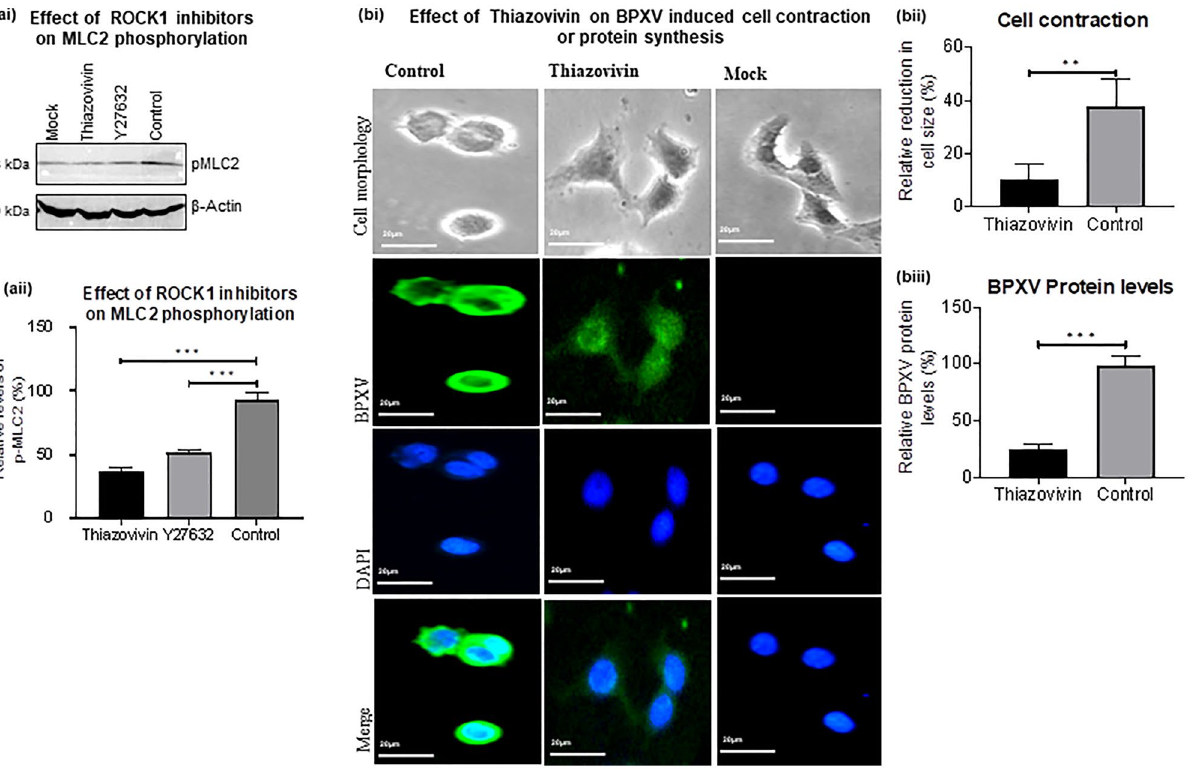
Figure 5. ROCK1 inhibition impairs BPXV-induced cell contraction and viral protein synthesis. ( a ) Effect of Thiazovivin on MLC2 phosphorylation (activation). Vero cells were either mock-infected or infected with BPXV at MOI of 5. Thiazovivin or vehicle controls were added at 4 hpi. Cell lysates were prepared at 9 hpi and subjected for detection of the p-MLC2 levels in Western blot analysis (ai). The histogram (aii) shows the band intensity of the protein. The blots were quantified by densitometry (ImageJ) and the data are presented as mean with SD. n = 3 independent experiments. See Supplementary Fig. 6e for full blots. ( b ) Effect of Thiazovivin on BPXV induced cell contraction and levels of viral proteins. HeLa cells were grown in chamber slides and infected with BPXV at an MOI of 5 for 1 h. Thiazovivin was applied at 4 hpi. At 15 hpi, BPXV (FITC) proteins were probed by immunofluorescence assay. Cell morphology and level of viral proteins of Thiazovivin-treated or untreated cells is shown (bi). The histogram shows the relative reduction in cell size (bii) and relative levels of BPXV proteins (biii) in Thiazovivin treated or untreated cells. The area (n = 50 cells) and the intensity of viral proteins (n = 50 cells) were quantified by ImageJ. The data are presented as mean with SD. Pair-wise statistical comparisons were performed using Student’s t-test (***P < 0.001; **P <